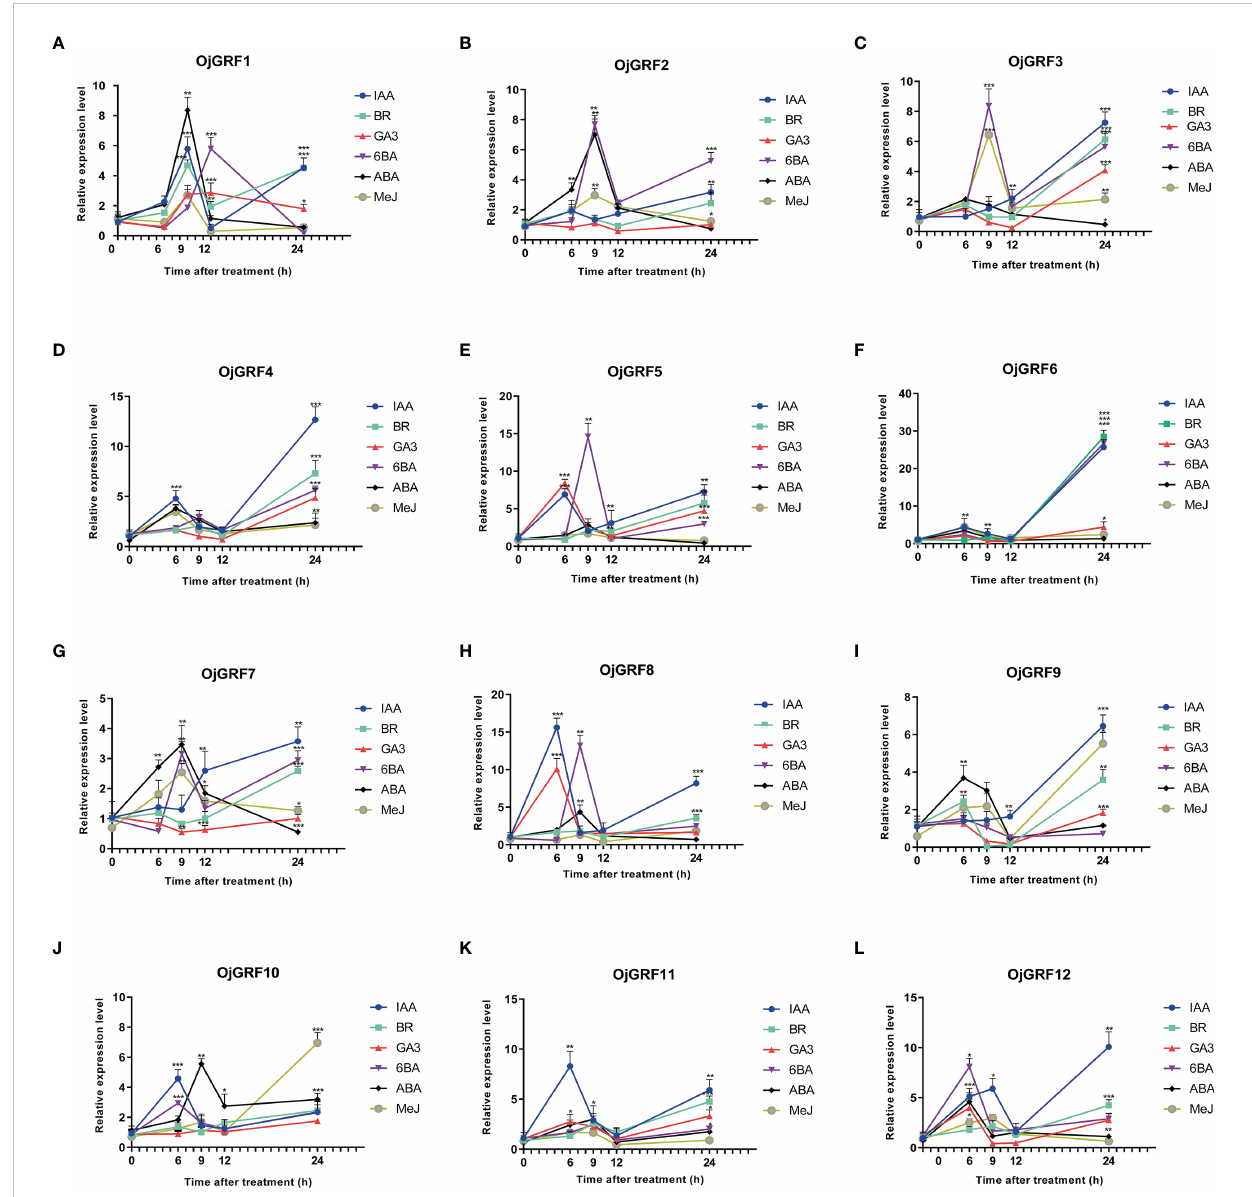
FIGURE 10 Analysis of the different expression patterns of GRF family members in rice under various hormonal treatments. (A – L) The expression of 12 GRFs in rice was calculated at 6, 9, 12, and 24 h of treatments compared with the expression value at 0h. The expression level of GRF was tested by qRT- PCR estimated by the 2 DD CT method. The error bars show the standard deviation of the three biological replicates. Student ’ s t-test was used in this experiment; *p < 0.05; **p < 0.01; ***p <